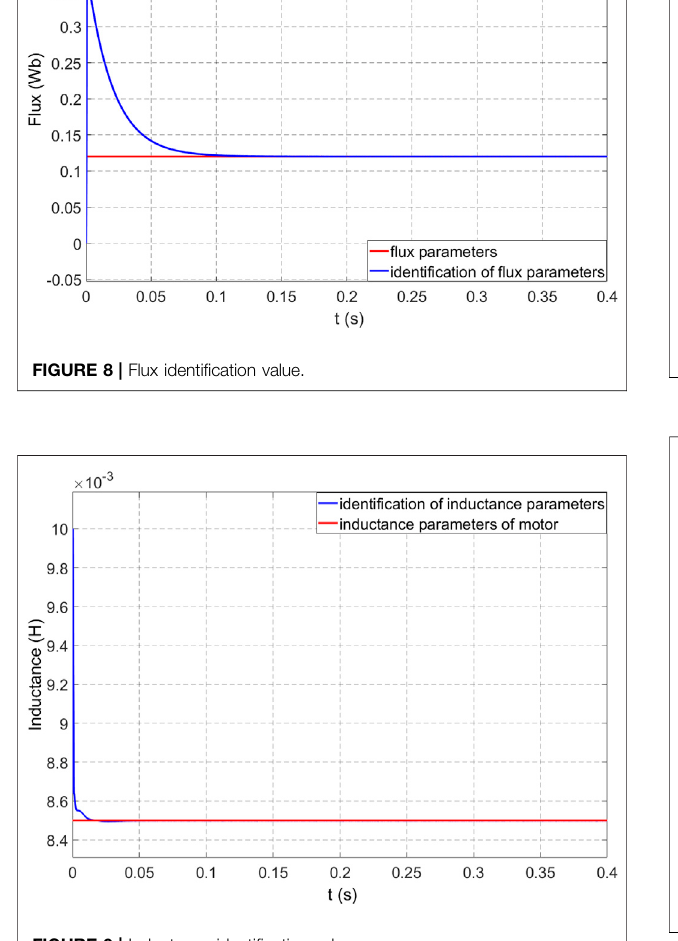
FIGURE 9 | Inductance identi fi cation value.